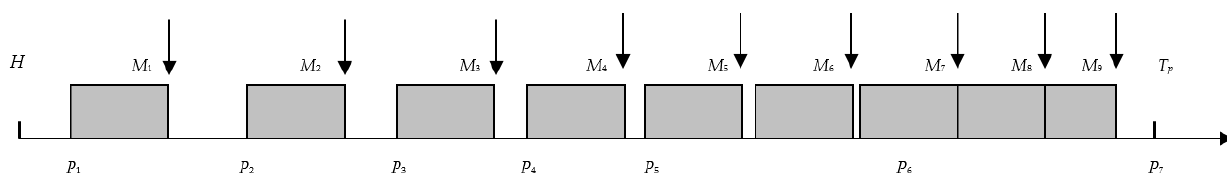
Figure 2. Safe time windows P n –M n (grey), moment H (today), moment T p (overhauling). Arrows represent inspection moments (authors’ figure).